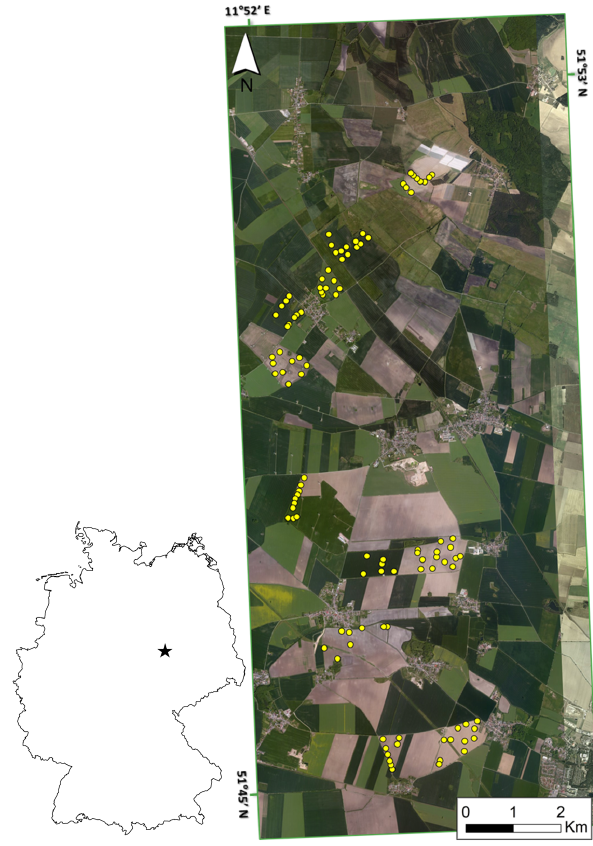
Figure 1. Locations of sample points and study area within Ger- many.